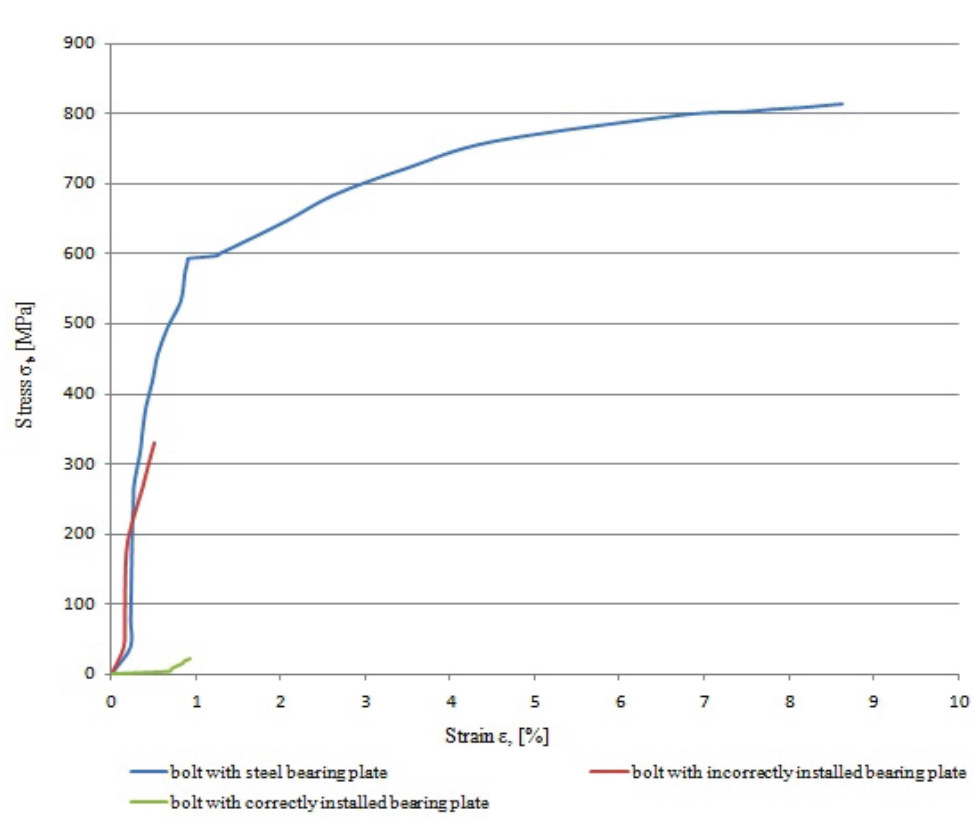
Fig. 11. Stress-strain characteristic of a long expansion rock bolt support with different bearing plates